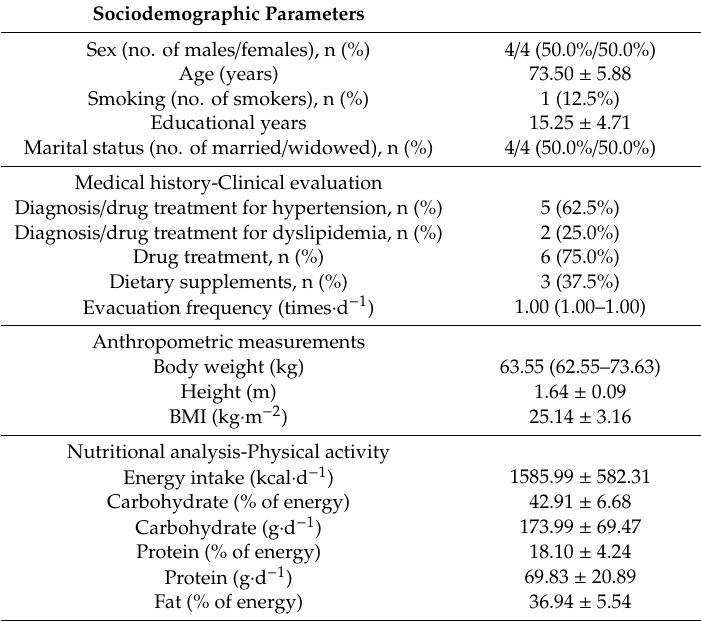
Table 2. Descriptive characteristics of fecal donors (n =